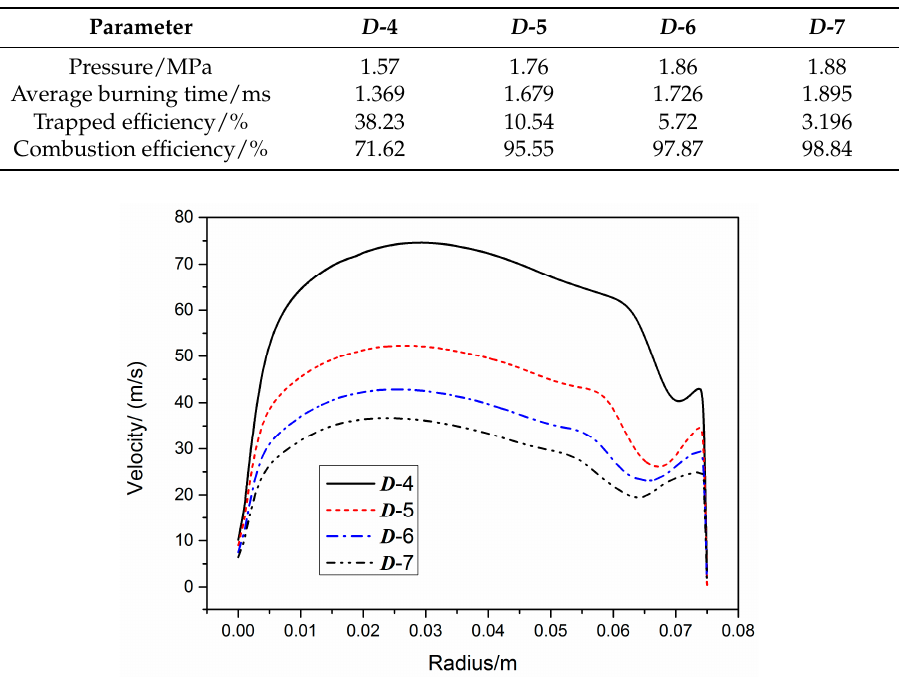
Figure 14. Velocity distribution curve.